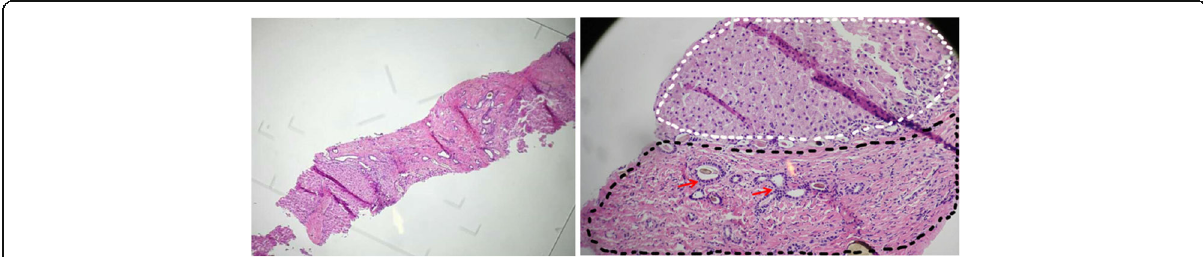
Fig. 4 Liver biopsy confirmed the features of Caroli ’ s syndrome in the patient. Liver biopsy showed thick, bridging fibrosis with bile ductular proliferation and dilation (the black dots indicate the portal area; the red arrow shows dilated bile ducts), and fibrous bands traversed the hepatic parenchyma, forming nodules (non-regenerative; indicated by the white dots). Left, lower magnification; right, higher